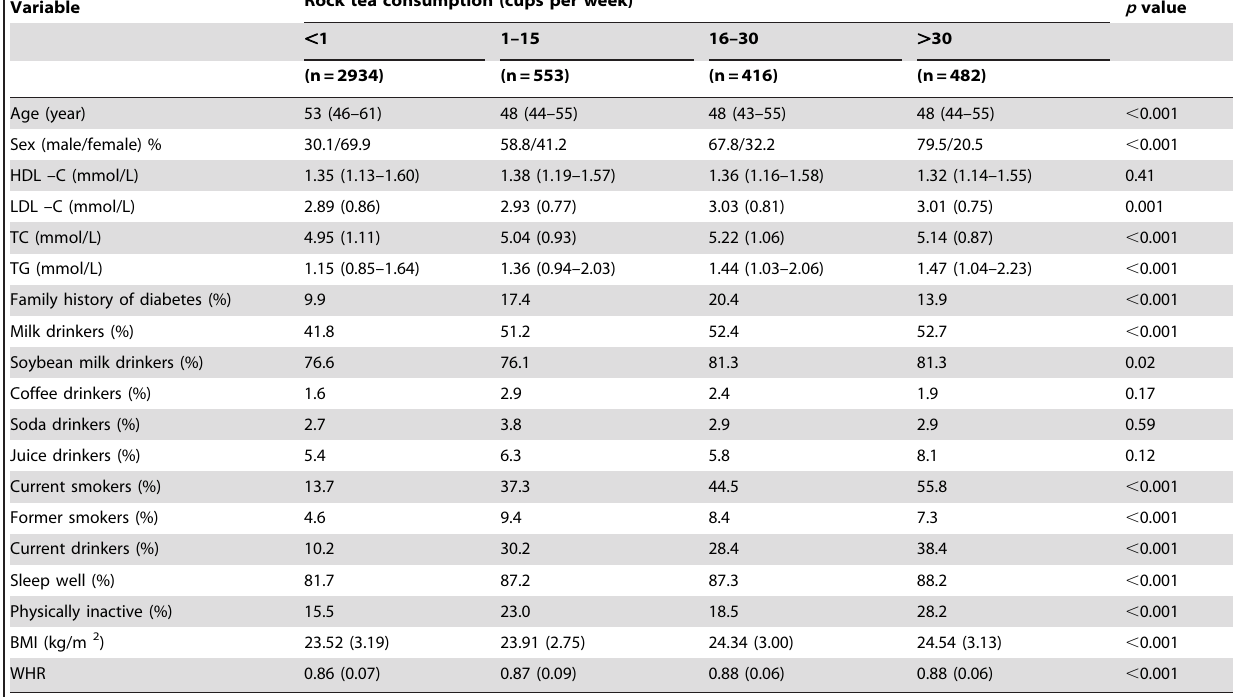
Variable Rock tea consumption (cups per